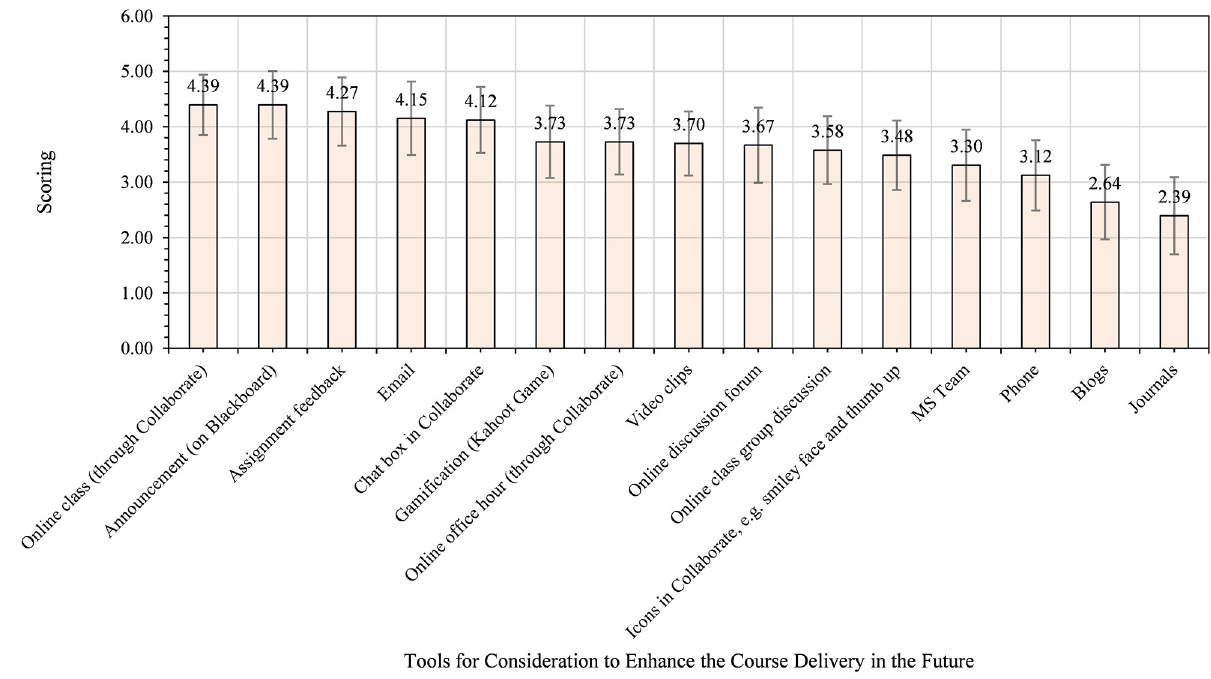
Fig 11. Health sciences and medicine students’ views on tools for enhancing course delivery in the future.